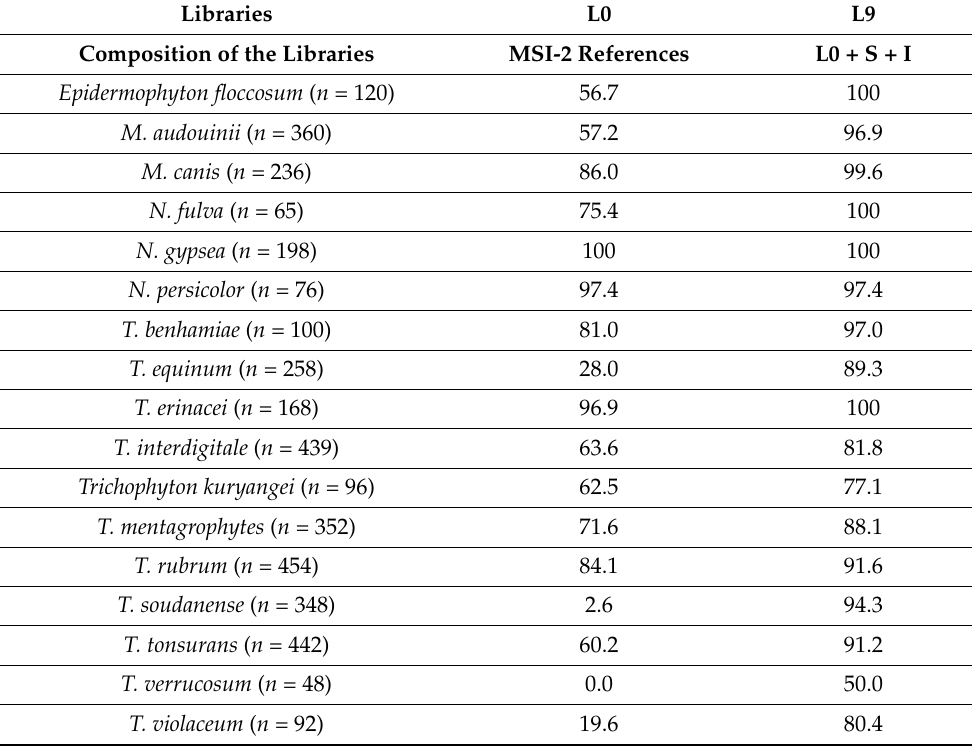
Table 2. Percentages of correct identification by species with the L0 and L9